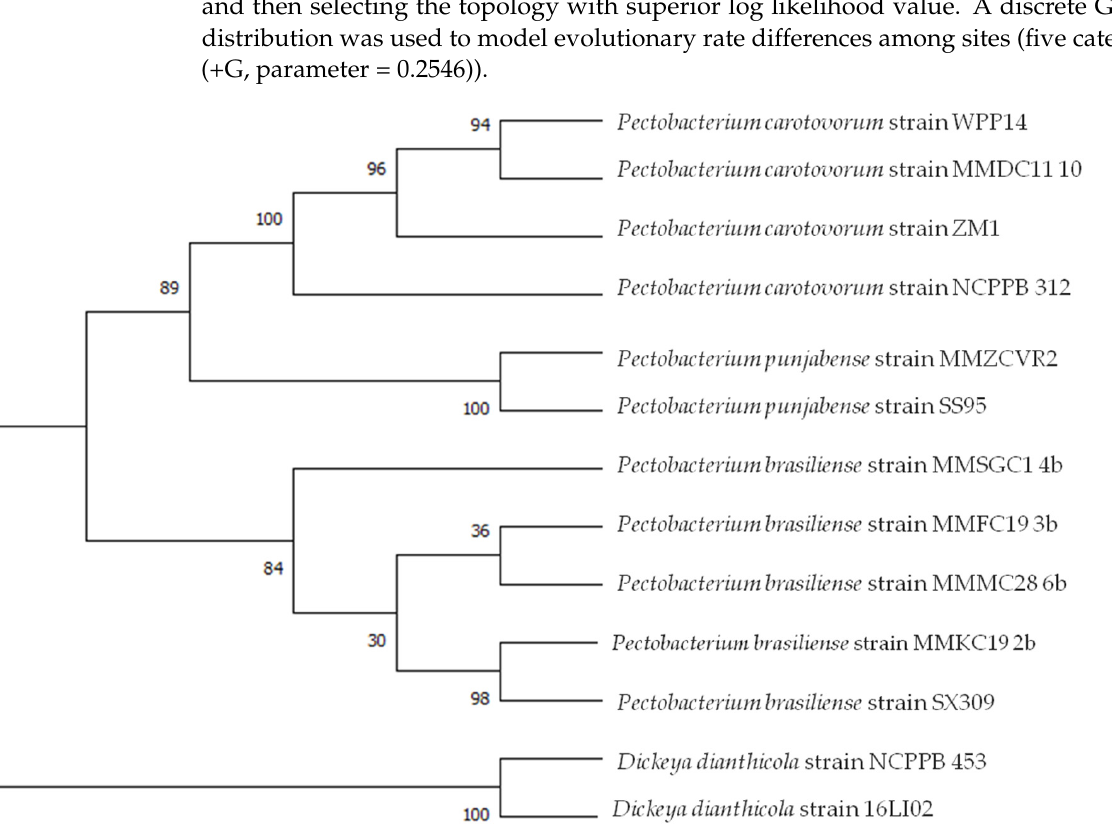
Figure 2. Multilocus sequence analysis of concatenated partial sequences of four housekeeping genes gyrA , recA, rpoA and rpoS of 13 Pectobacterium strains. Maximum likelihood tree built using MEGA X. D. dianthicola strains NCPPB 453 and 16LI02 served as an outgroup. Bootstrap values were calculated using 1000 replicates.